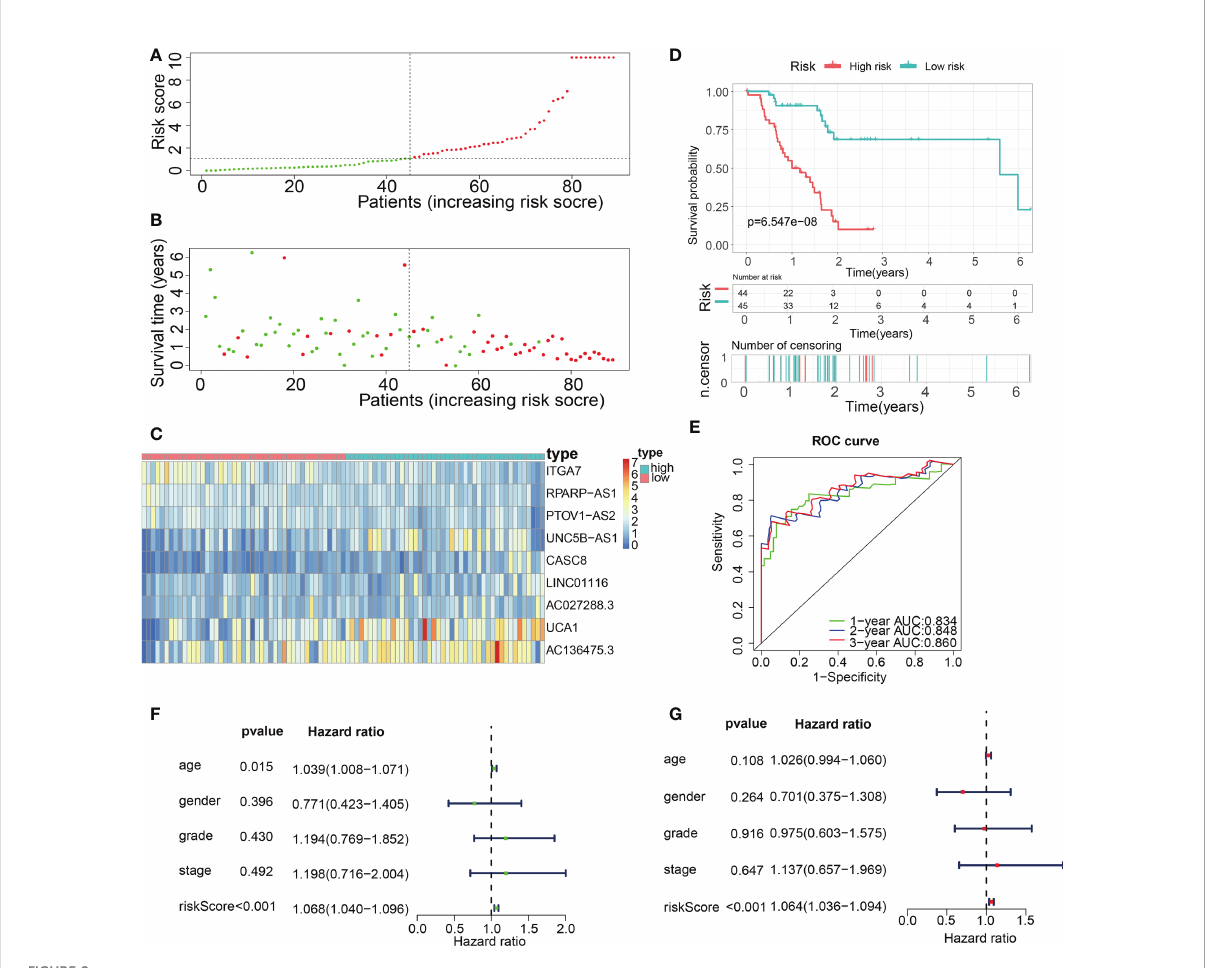
FIGURE 8 Construction of a novel ECM-APP in the train cohort. (A) Sectionalization premised on the median risk score. (B) Survival status and risk score distributions (C) Heatmap depicted the expression levels of 9 genes integrated into the prognostic signature. (D) Survival curve of OS time in low-risk and high-risk subgroups. (E) ROC curve of 1-, 2-, and 3-years of train cohort, area under the curve (AUC) of the curve are 0.834, 0.848, and 0.860, correspondingly. (F) Univariate cox regression analysis illustrated the independence of risk score, gender, grade, stage, and age. (G) Multivariate cox regression analysis showed the independence of risk score, stage, grade, gender, and